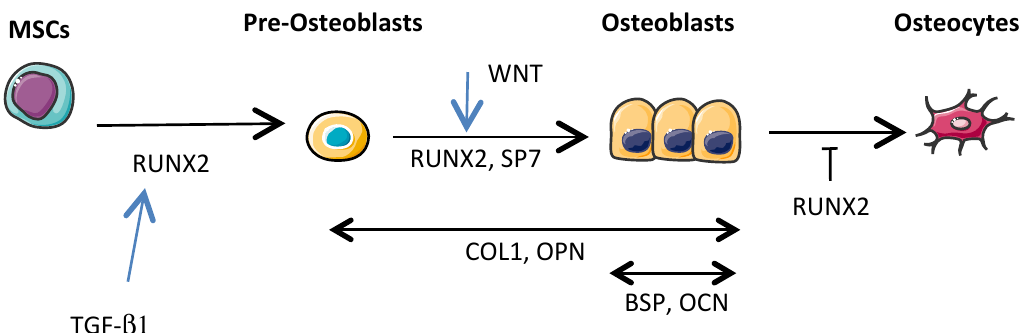
Figure 3. Osteoblastic differentiation from mesenchymal stem/stromal cells (MSCs) to osteocytes. Transcription factor RUNX2 promotes MSC commitment toward the osteoblastic lineage at the early stages while repressing maturation in osteocytes. SP7 allows the differentiation of pre-osteoblasts into functional mature osteoblasts. RUNX2 induces expression of genes coding for expression of collagen type 1 (COL1), osteopontin (OPN), bone sialoprotein (BSP) and osteocalcin (OCN) proteins. Transforming growth factor- β (TGF- β1) and WNT stimulate early stages of osteoblastic differentiation.